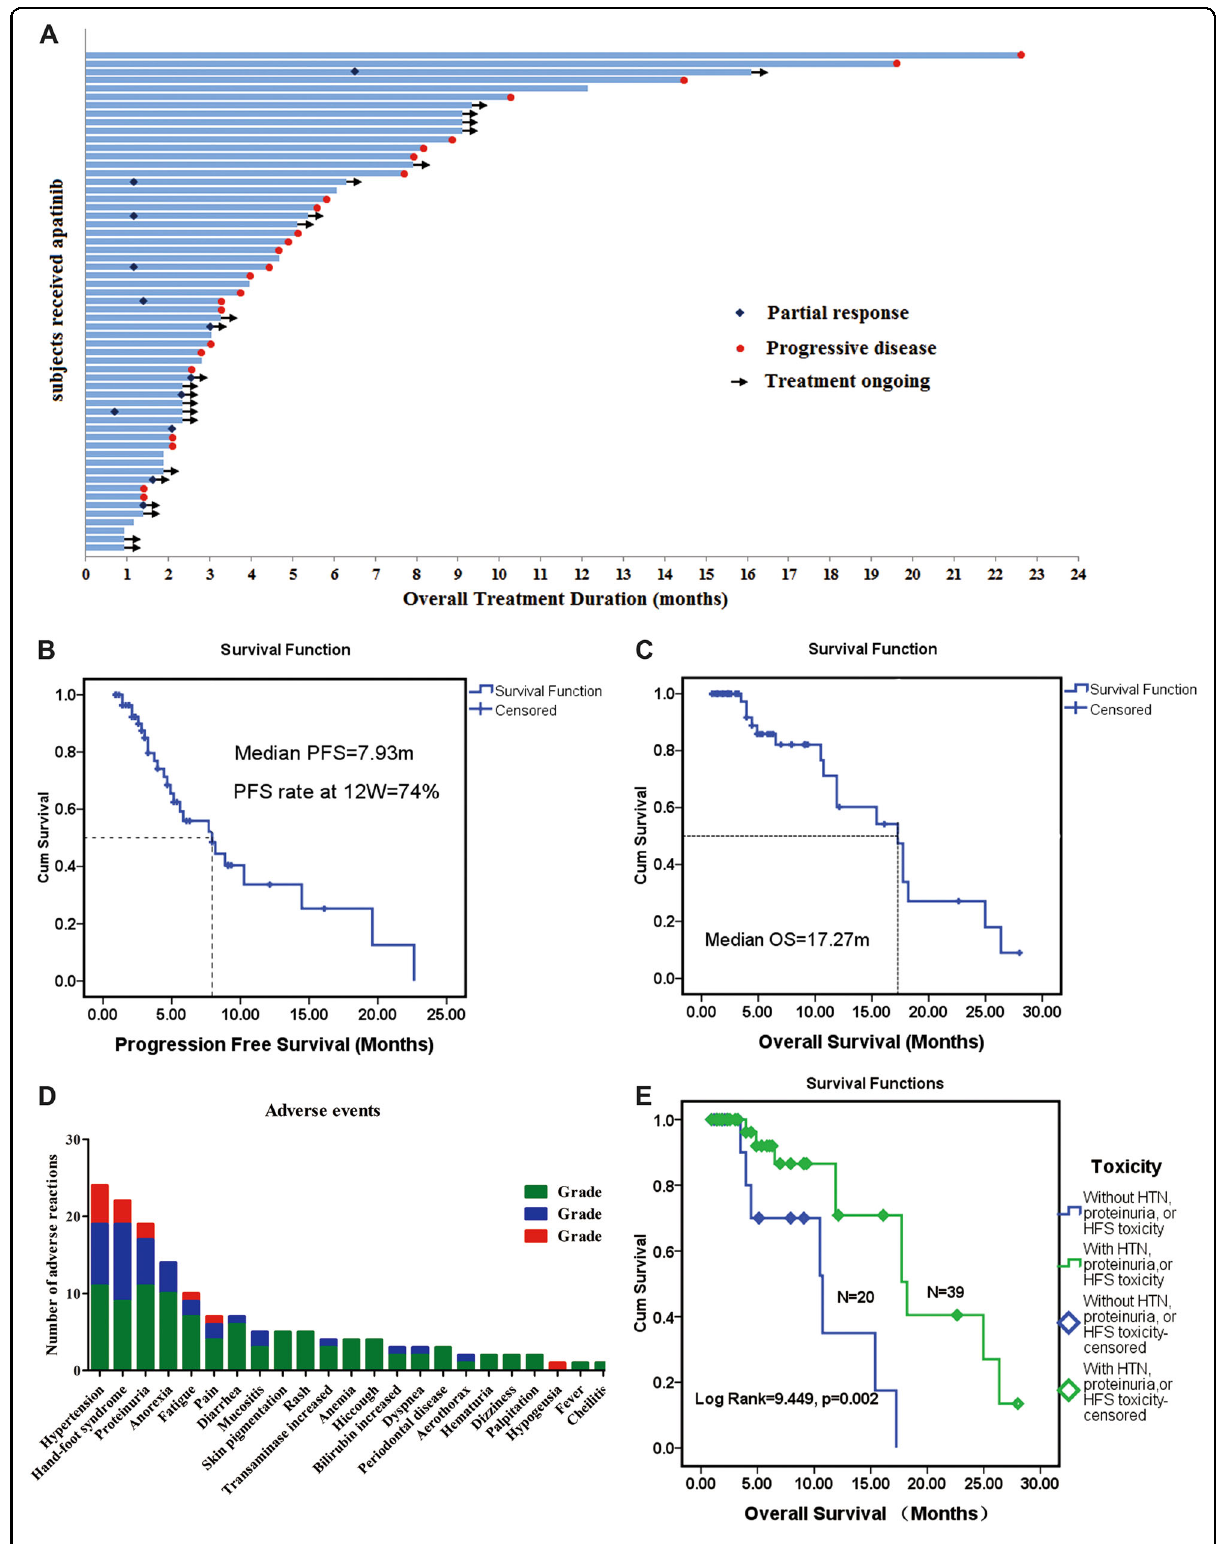
Fig. 2 (See legend on next